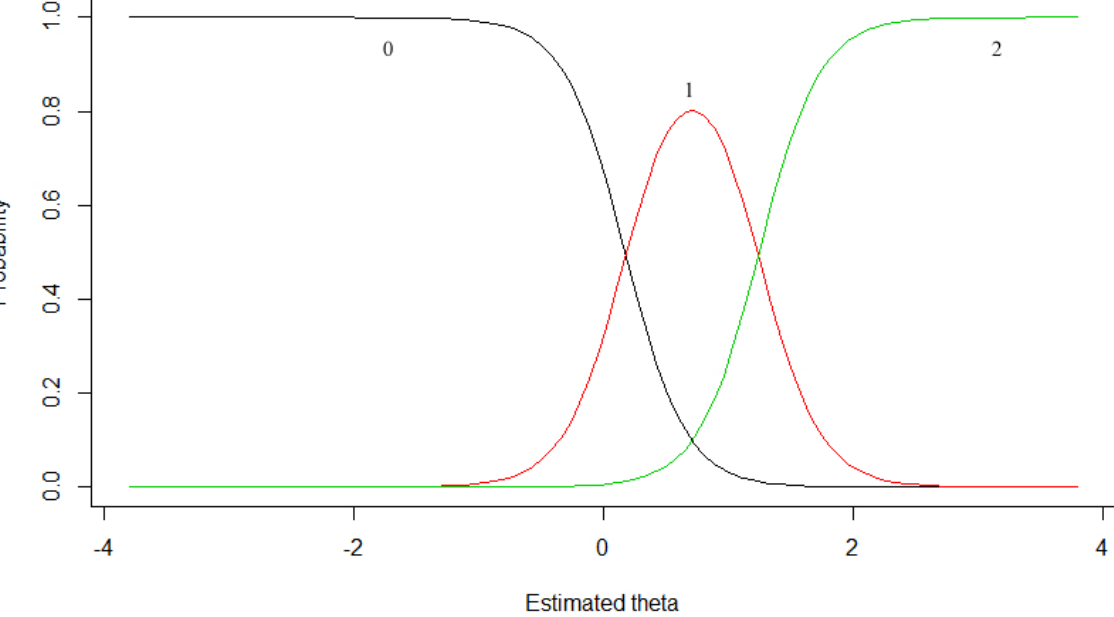
Figure 1. Example of category response curve for item 7 (frequency of thinking about suicide). Number and colors (0: black; 1: red; 2: green) reflect answer